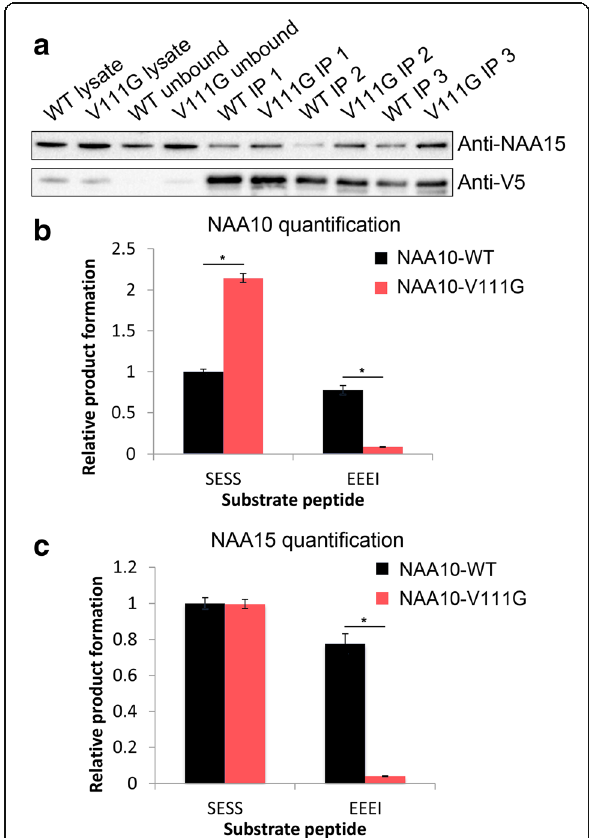
Fig. 3 NAT-activity of immunoprecipitated NAA10-WT-V5 and NAA10-V111G-V5. a Western blot of immunoprecipitated NAA10- WT-V5 and NAA10-V111G-V5 using anti-V5. b Catalytic activity of immunoprecipitated NAA10-WT-V5 and NAA10-V111G-V5 correlated towards the amount of NAA10-V5 present in each sample. c Catalytic activity of immunoprecipitated NAA10-WT-V5 and NAA10-V111G-V5 correlated towards the amount of NAA15 present in each sample. NAT activity experiments were performed in triplicates. * statistically significant ( p <0.0001, student t-test). The data presented are representative for